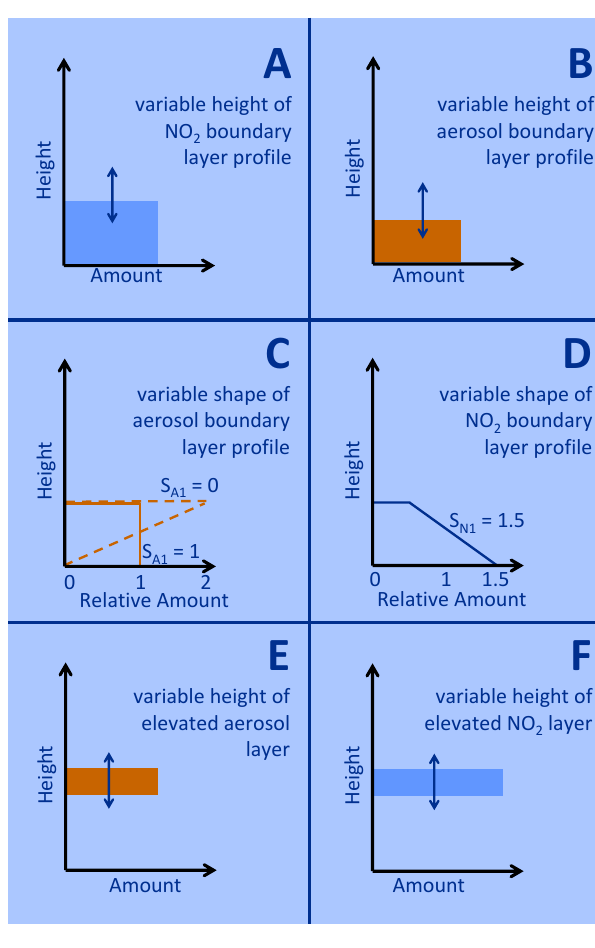
Fig. 6. Schematic of the six sensitivity studies (A–F) performed to test the behavior and robustness of the NO 2 profile retrieval al- gorithm. Each diagram only shows the parameter that is changed, other fixed parameters are given in Table 2. The top row shows the first two studies, that were done to check the behavior of the al- gorithm for various levels of artificial noise, under conditions that coincide with the model assumptions. The second row illustrates the study that was done to test the effect of inhomogeneous distri- butions within the boundary layer of aerosols or NO 2 (whereas the retrieval model assumes homogeneous distributions for both). The shape parameter S defines the various profile shapes. Finally we tested the sensitivity of the NO 2 retrieval to elevated aerosol and NO 2 layers (third